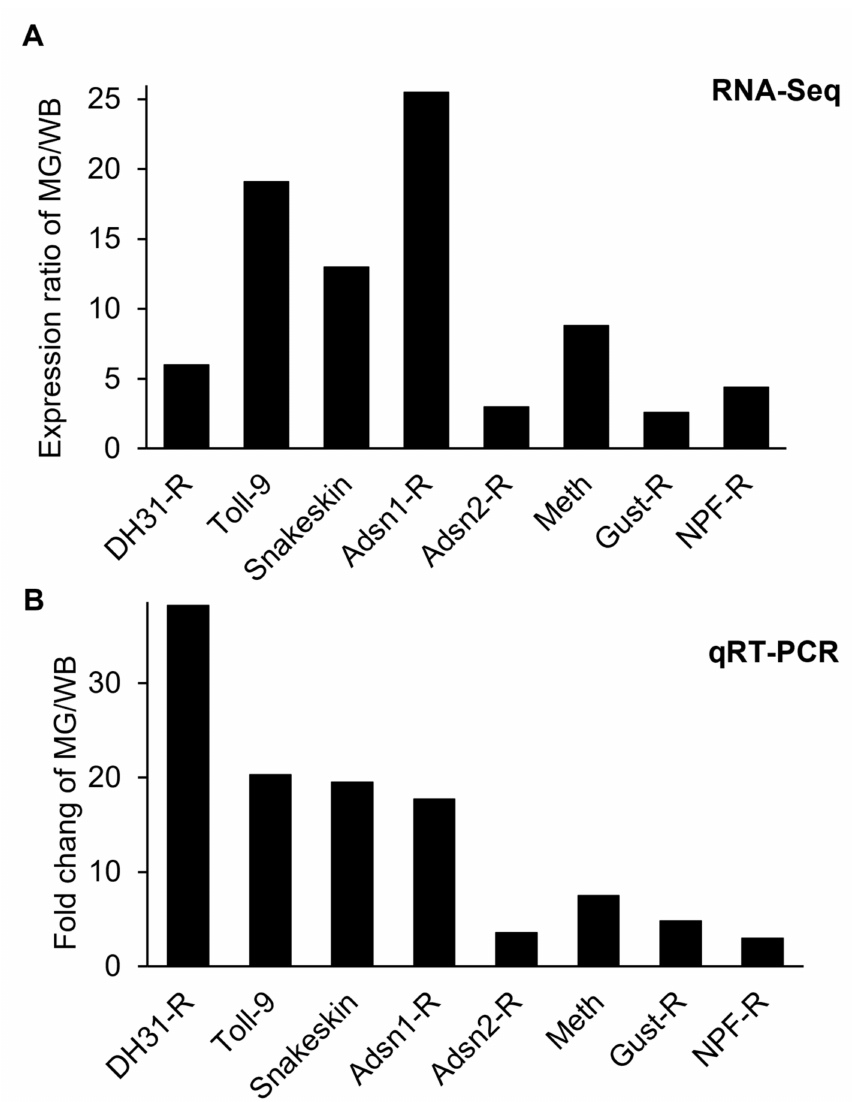
Figure 4. Expression of membrane protein genes in the midgut of Drosophila suzukii as measured by RNA-Seq ( A ) and qRT-PCR ( B ). Ratios of FPKM (fragment per kilobase of transcript per million mapped reads) and FC (fold change) of the midgut (MG)/whole-body (WB). DH31-R: diuretic hormone 31 receptor; Adsn1&2-R: adhesion receptor1 and 2; Meth: methuselah; Gust-R: gustatory receptor; NPF-R: neuropeptide F